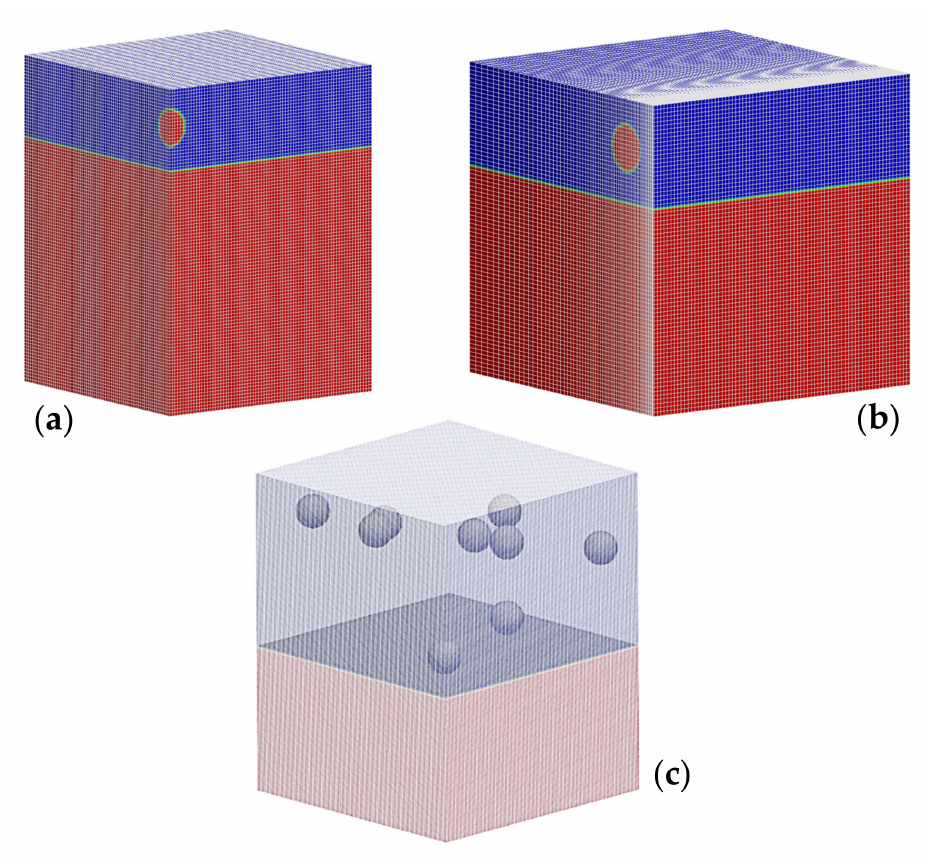
Figure 1. Domain and mesh (drawn at half the real refinement level, for better visualization) for the single ( a ), double ( b ), and multiple ( c ) impact